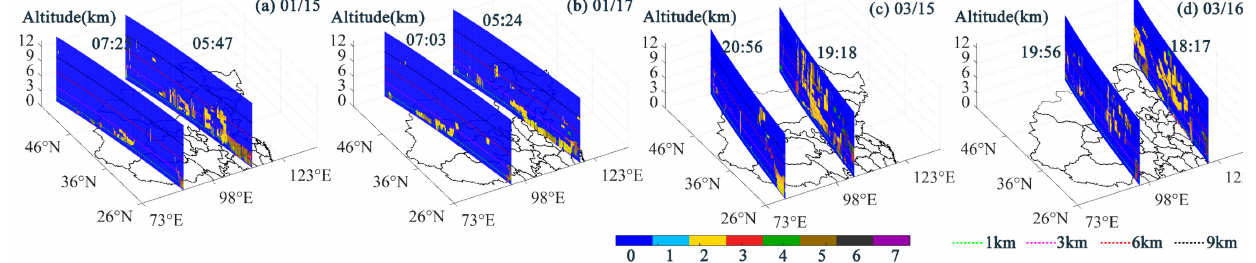
Figure 6. CALIOP VFM images on January 13 ( a ), January 15 ( b ), March 15 ( c ), and March 16 ( d ). (0 = Not Determined, 1 = Clean Marine, 2 = Dust, 3 = Polluted Continental/Smoke, 4 = Clean Continental, 5 = Polluted Dust, 6 = Elevated Smoke, 7 = Dusty